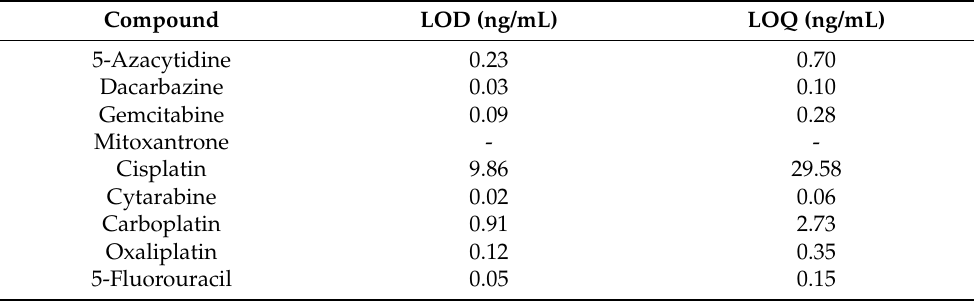
Table 4. LOD and LOQ values obtained for each